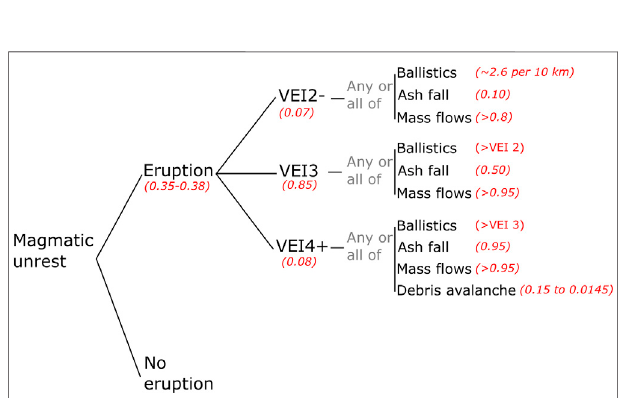
FIGURE11| Simpli fi edconditionalprobabilitychainwithprobabilitiesfor main hazards to affect Taranaki Crossing project tracks in the next 50 years. Ashfall probabilities relate to the probability of > 10 cm of ashfall falling on Taranaki Crossing project tracks.